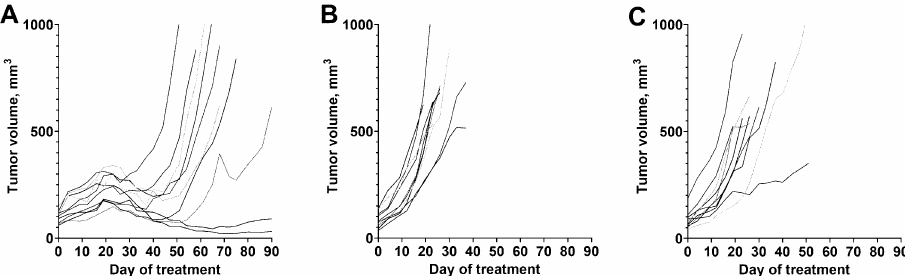
Figure 10. The growth of individual tumors in mice treated with ( A ) 188 Re-ZHER2:41071 (three times with 5 µg, 16 MBq, dissolved in 10% ethanol in 0.9% saline), ( B ) non-labeled ZHER2:41071 (three times with 5 µg, dissolved in 10% ethanol in 0.9% saline), and ( C ) vehicle (three times with 10% ethanol in 0.9% saline).